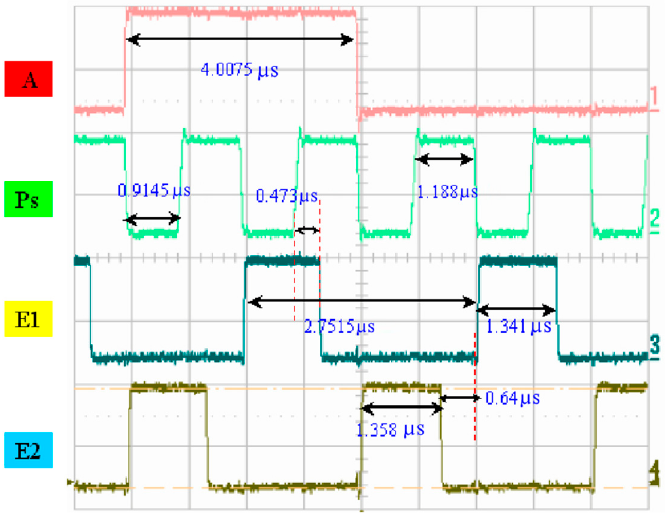
Figure 8. Time-scale testing.